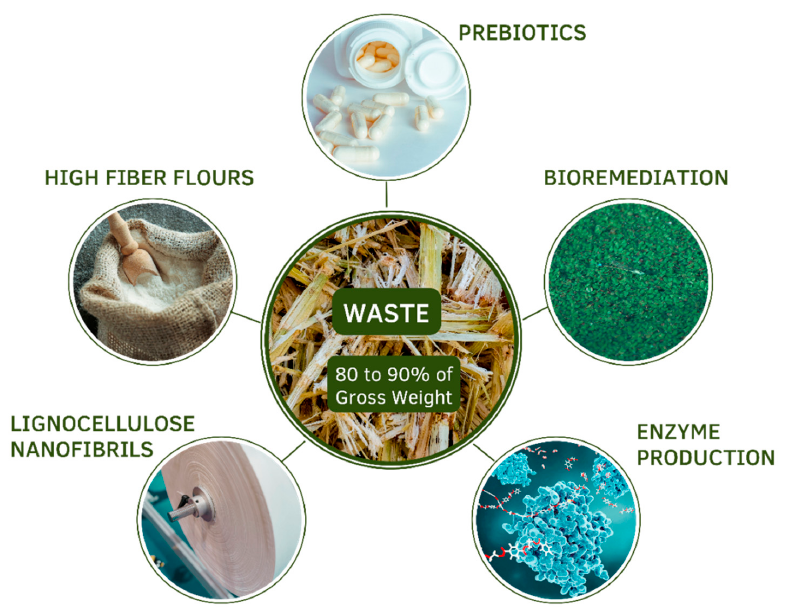
Figure 4. Upcycling of B. gasipaes lignocellulosic wastes can generate valuable biotechnological products. The median sheaths and stem parts can be processed into high fiber flours; the inner sheath and stem bark xylans are material for the obtainment of xylooligosaccharides (prebiotics); the leaf sheath can be used as a substrate for solid-state fermentation and bioremediation; the peach-palm waste can be a substrate for enzyme production, and lignocellulose nanofibrils can be extracted from the outer